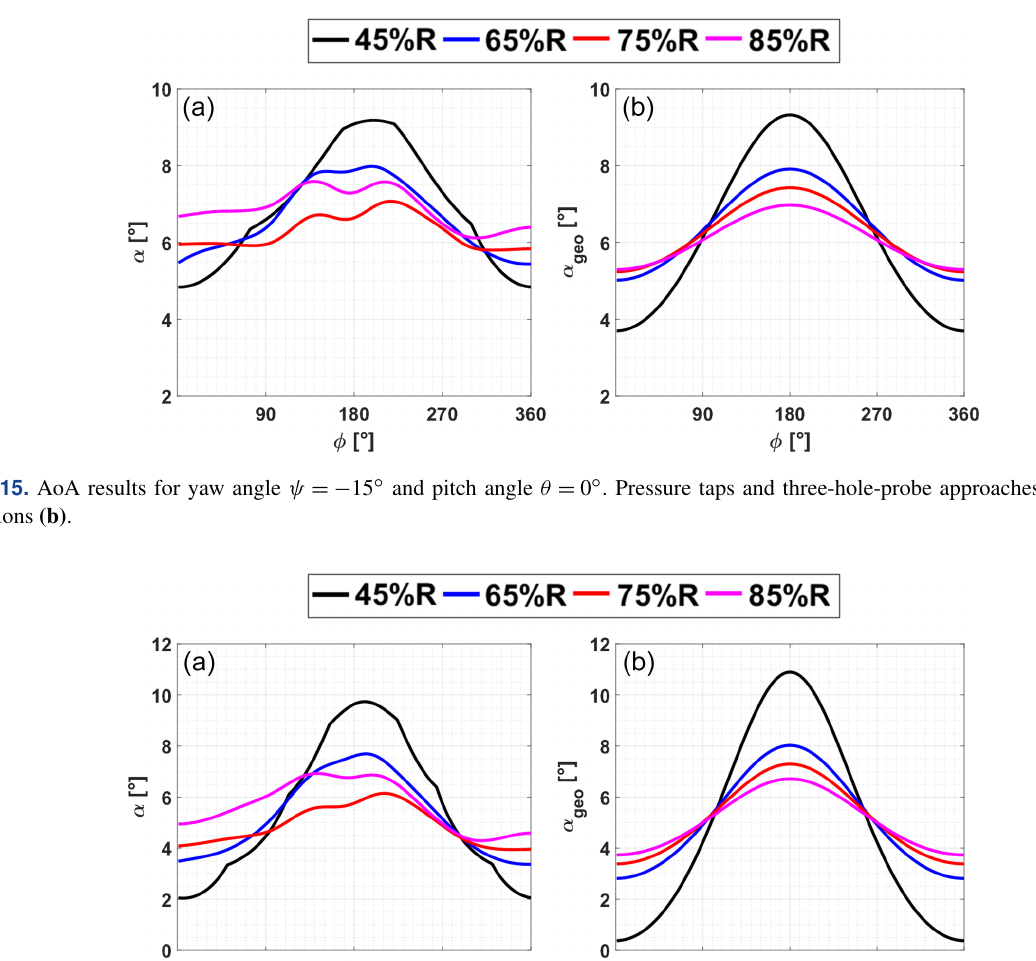
Figure 14. AoA results for yaw angle ψ = 0 ◦ and pitch angle θ = 0 ◦ . Pressure taps and three-hole-probe approaches (a) . Analytical calcu- lations (b) .